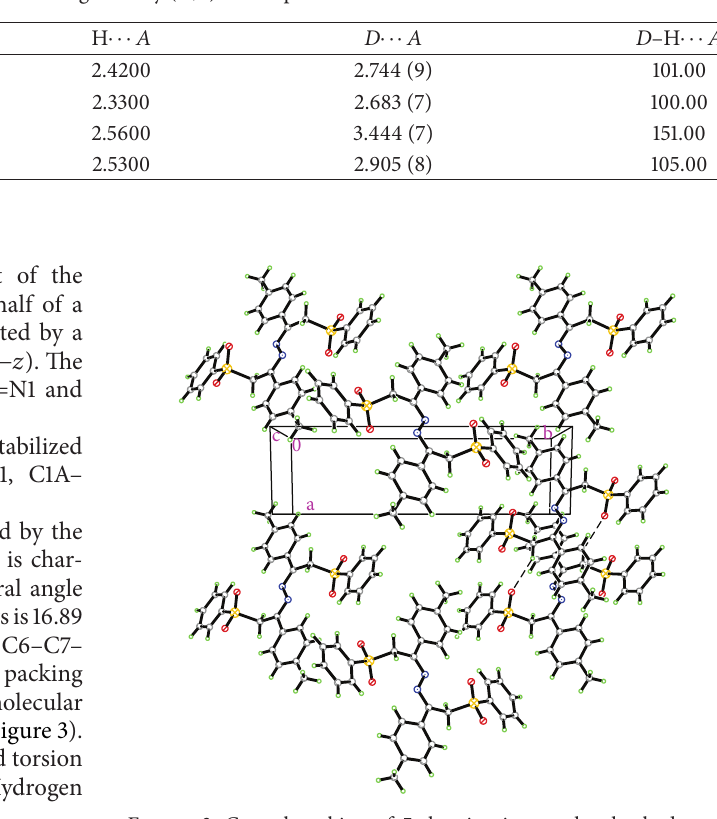
Figure 3: Crystal packing of 5 showing intermolecular hydrogen bonds as dashed